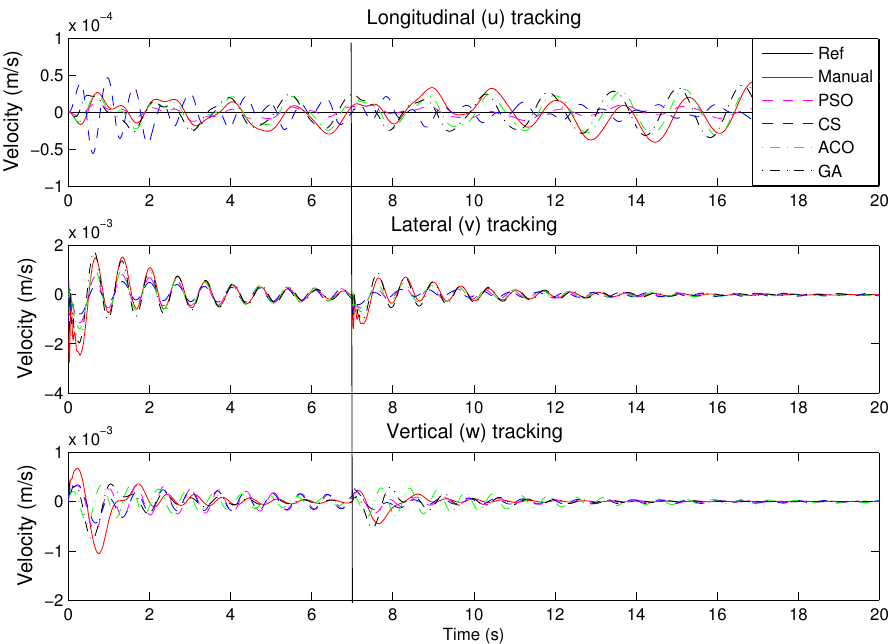
Figure 15. The speed of the rotorcraft in response to starboard gust disturbance at